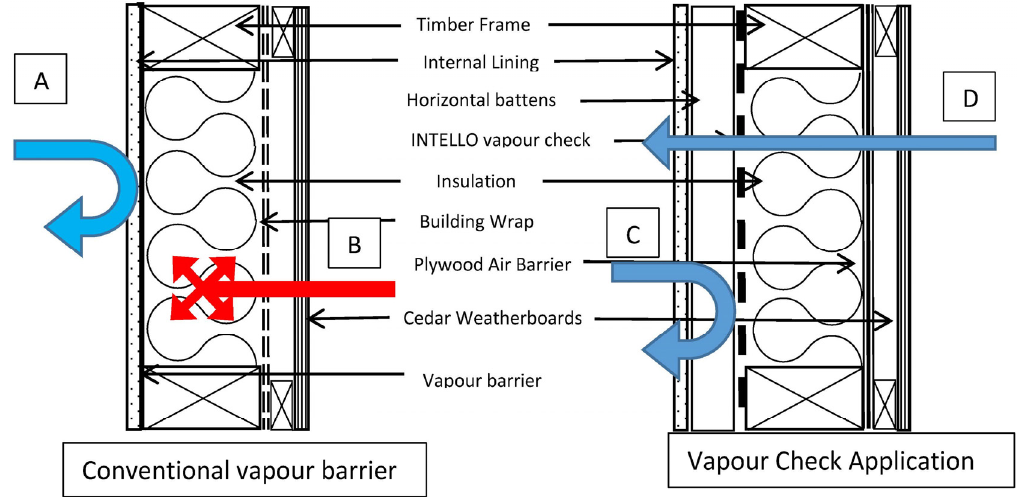
Figure 1. Moisture flows through the